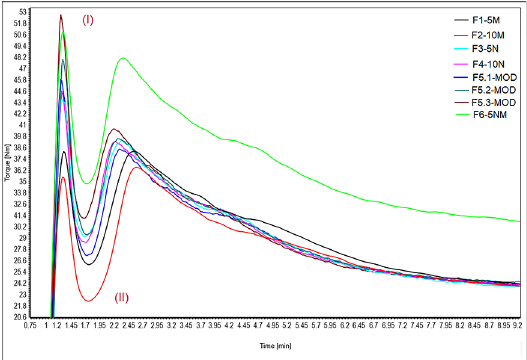
Figure 2. Gelation curve/melting of formulation from 1 to 6.